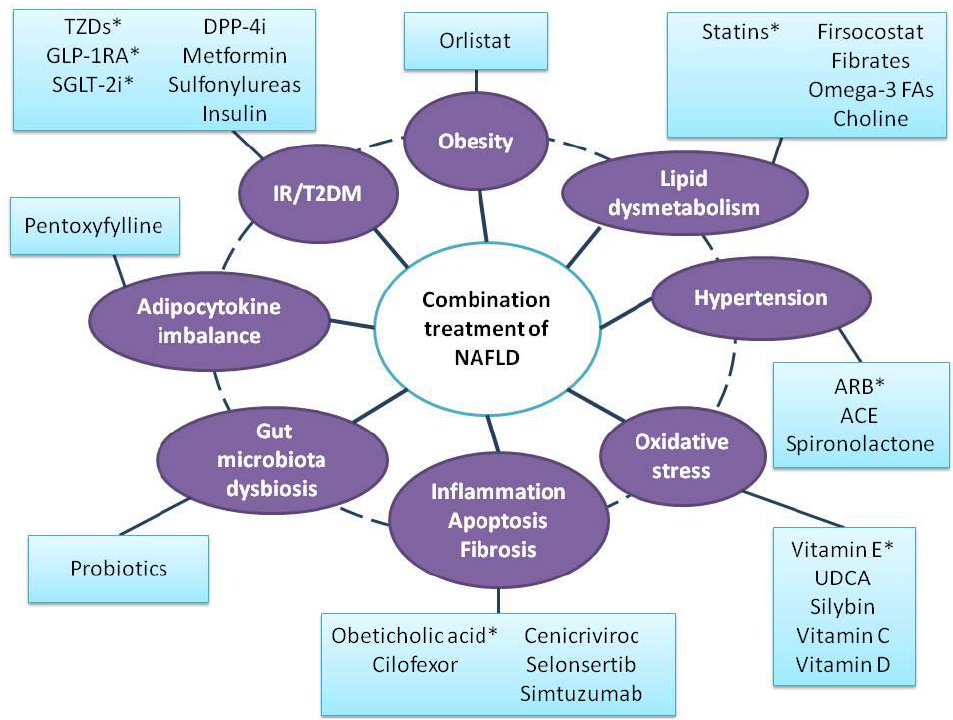
Figure 1. The multifactorial pathophysiology of NAFLD with possible medications investigated in combination. NAFLD has been characterized as a “multiple-hit” disease. Lipid dysmetabolism, insulin resistance, adipocytokine dysregulation, gut–liver axis dysfunction, oxidative stress and genetic predisposition are considered the main factors that trigger hepatic steatosis and the progression to inflammation and fibrosis. In parallel to these contributors, several co-morbidities such as obesity, T2DM, dyslipidemia and hypertension, lie in parallel with NAFLD, leading to increased morbidity and mortality. The multifaceted pathogenesis of the disease and the failure of current monotherapies to provide a definite solution to the management of NAFLD may inspire a shift of research towards combined therapies. Each category indicates all potential medications that have been used in combination with at least another one medication within the same or another category. Medications highlighted with an asterisk (*) have provided more favorable results and may be more eligible for future research with combination treatment in NAFLD. It is highlighted that some medications may act with more than one mechanism. Abbreviations: ACE—angiotensin-converting enzyme; ARB—angiotensin receptor blocker; DPP-4i—dipeptidyl peptidase-4 inhibitors; FAs—fatty acids; GLP-1RA—glucagon-like peptide-1 receptor agonists; IR—insulin resistance; SGLT-2i—sodium glucose cotransporter-2 inhibitors; TZDs—thiazolidinediones; T2DM—type 2 diabetes mellitus; UDCA—ursodeoxycholic